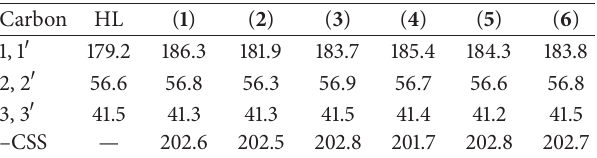
Table 4: 13 C NMR data a,b (ppm) of heterobimetallic Zn(II) and Sn(IV) complexes with